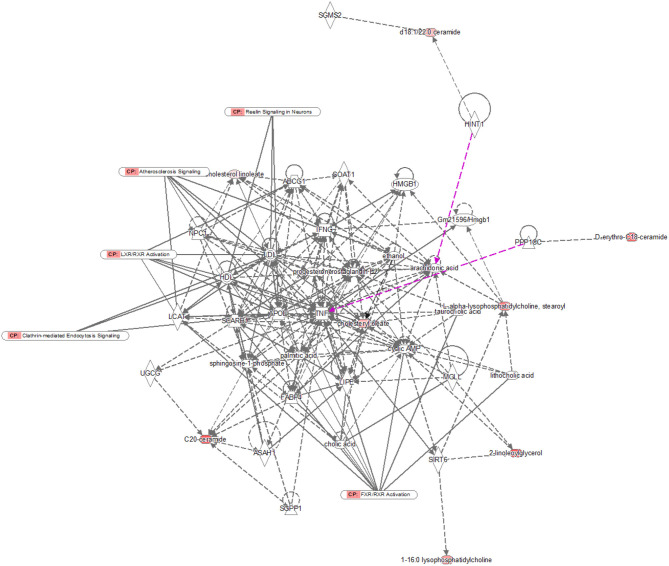
IPA prediction networks of significantly different lipids. The significantly different lipids were imported into the IPA software for pathway analysis. Direct connections are shown via solid lines, while indirect interactions are shown via dashed lines. IPA, ingenuity pathway analysis.